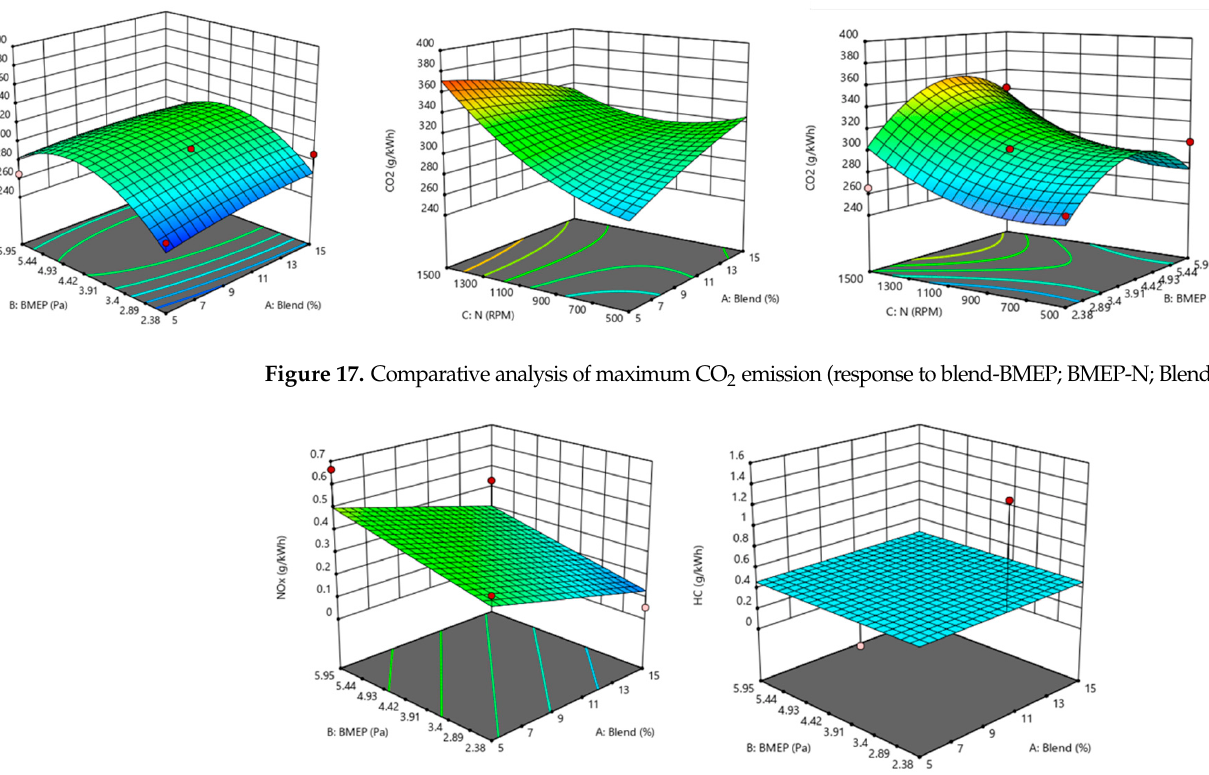
Figure 16. Comparative analysis of maximum CO emission (response to blend-BMEP; BMEP-N; Blend-N).